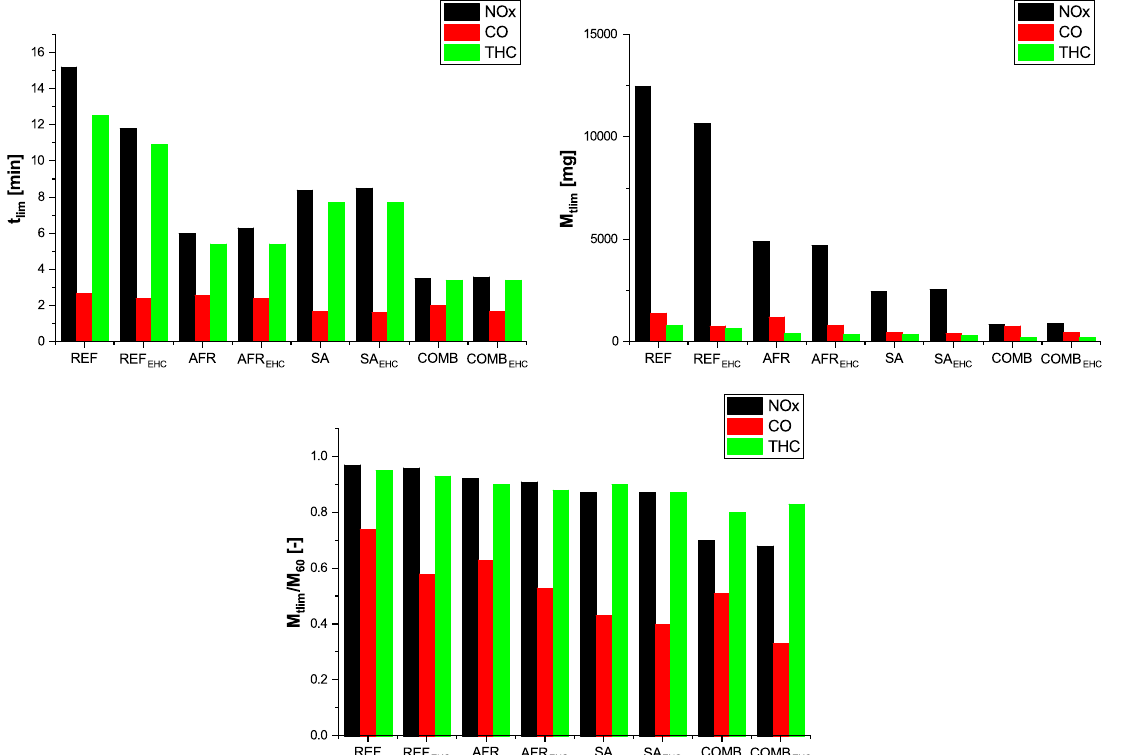
Figure 8. The variable t lim denotes the time until the emission concentration falls below 50 mg/m 3 (NO x and CO) and 10 mg/m 3 (THC), while M t represents the accumulated mass during t lim . lim M tlim in the total emission mass produced during represents the share of M t The ratio M 60 lim